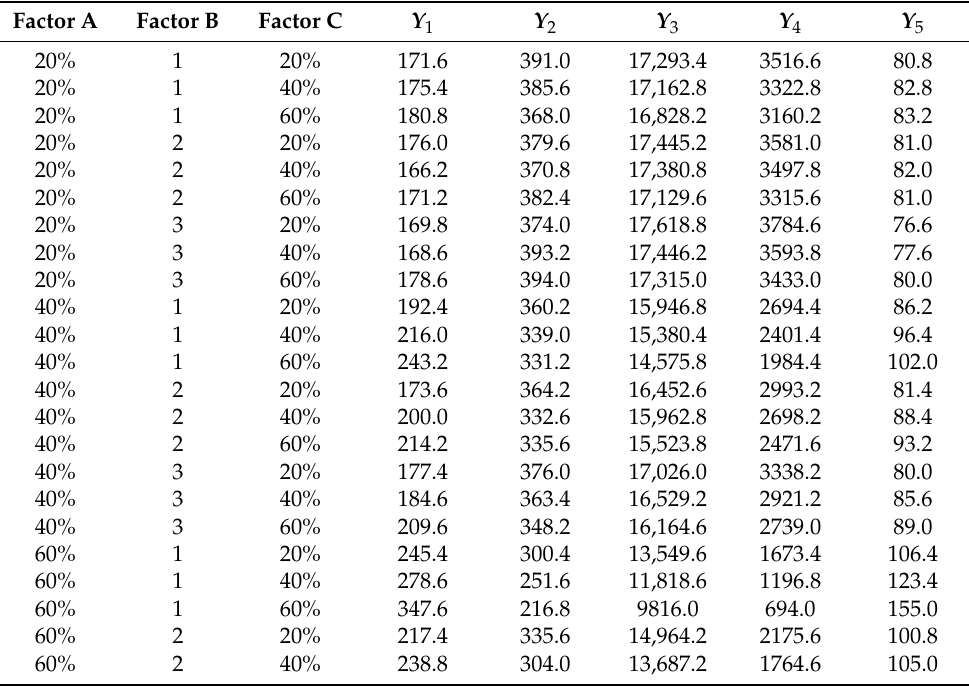
Table 3. Simulation results for each treatment